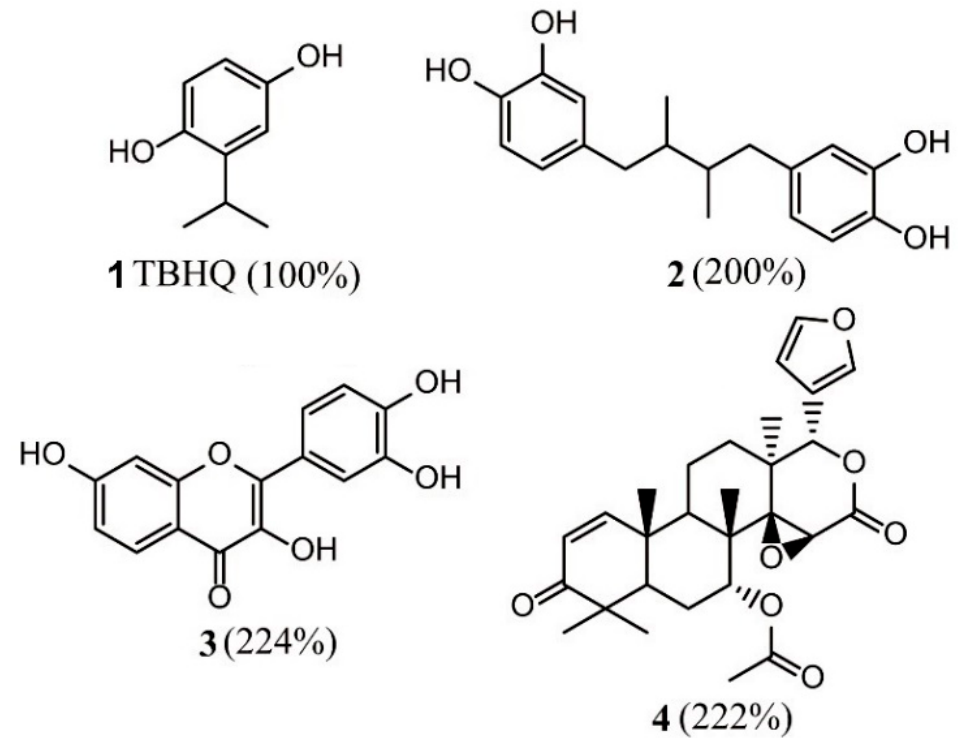
Figure 4. Structures of compounds 1–4 . TBHQ = tert-butylhydroquinone.